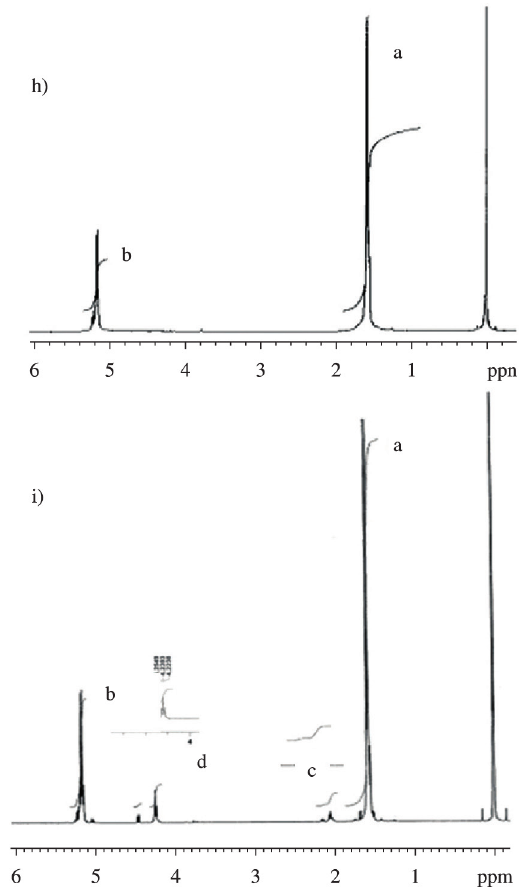
Figure 2. Comparison of the h spectrum for PLDLA and the i spectrum for PLDLA-TMC. Note the protons characteristic of TMC in the latter